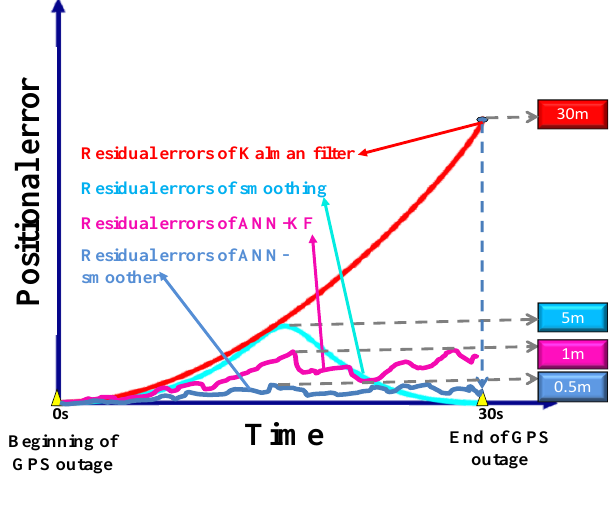
Figure 6. The error behaviors of hybrid model during GPS